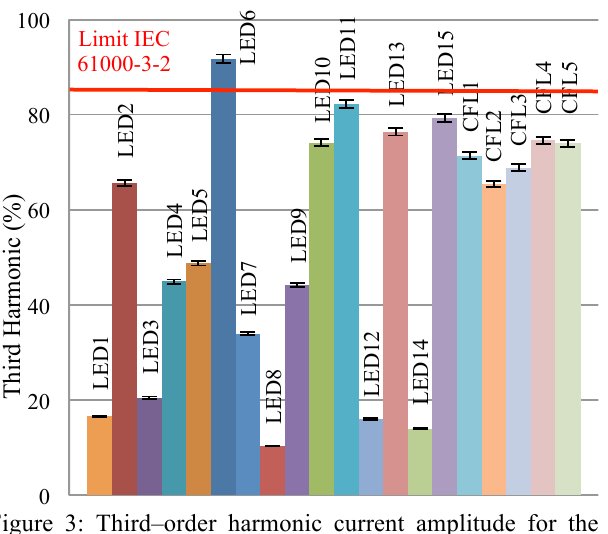
Figure 3: Third–order harmonic current amplitude for the lamps used.